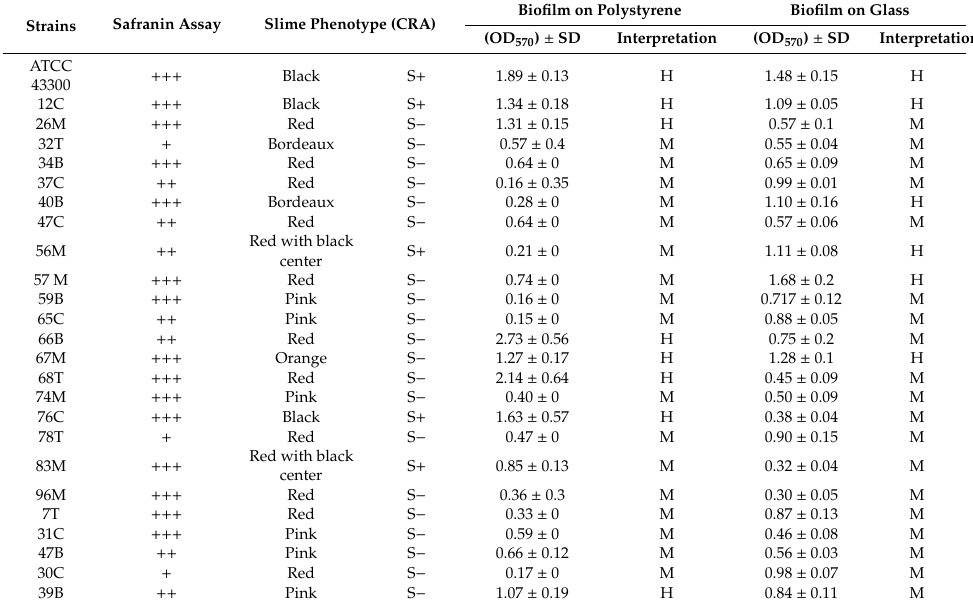
Table 4. Exopolysaccharide production (CRA), glass adhesion (Safranin 1%), and biofilm formation on polystyrene and glass by Staphylococcus spp. strains.